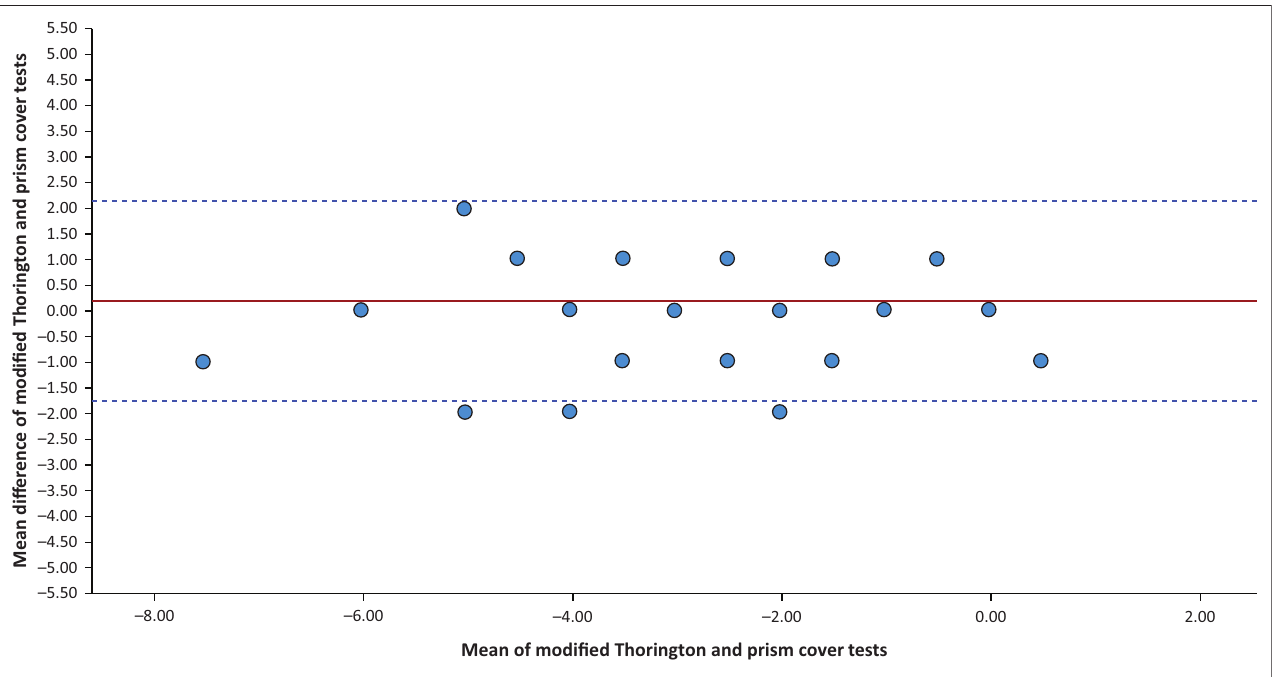
FIGURE 2: Bland–Altman plot showing the agreement between modified Thorington test and prism cover test. The central red line indicates the mean difference (= 0.17 Δ in Table 4) between the measurements. Observing the graph, many points are located relatively close to the red solid line that represents the mean difference. The two outer lines indicate the upper and lower limits of the 95 % limits of agreement (LoA) interval. The smaller this region and the closer to zero, the greater is the level of agreement between the two samples concerned. The units for the horizontal and vertical axes are prism dioptres.